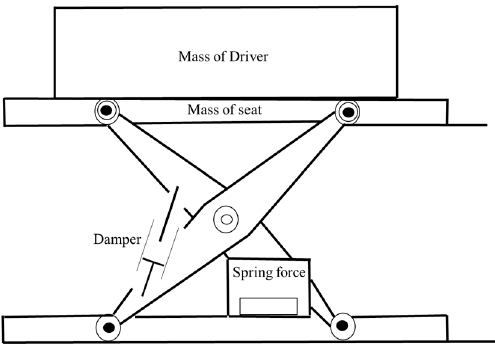
Figure 4. The main parts of the passive seat suspension [6].